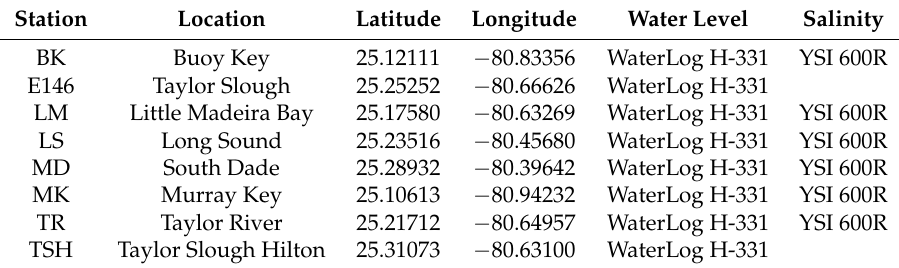
Figure 1. Physiographic map of South Florida representing different ecological domains dictated by topography, hydrology and climate. Hydrographic stations are denoted with abbreviations; for example, LM for Little Madeira Bay (Table 1). Everglades National Park (green border) covers the majority of the region with coastal hydrographic stations in Florida Bay (MK, BK, LM, LS, MD) and extending upstream to Taylor Slough (TR, E146, TSH). Urban, suburban and agricultural lands featuring water management canal infrastructure can be seen between Everglades and Biscayne National Parks (blue border). Table 1. Hydrographic